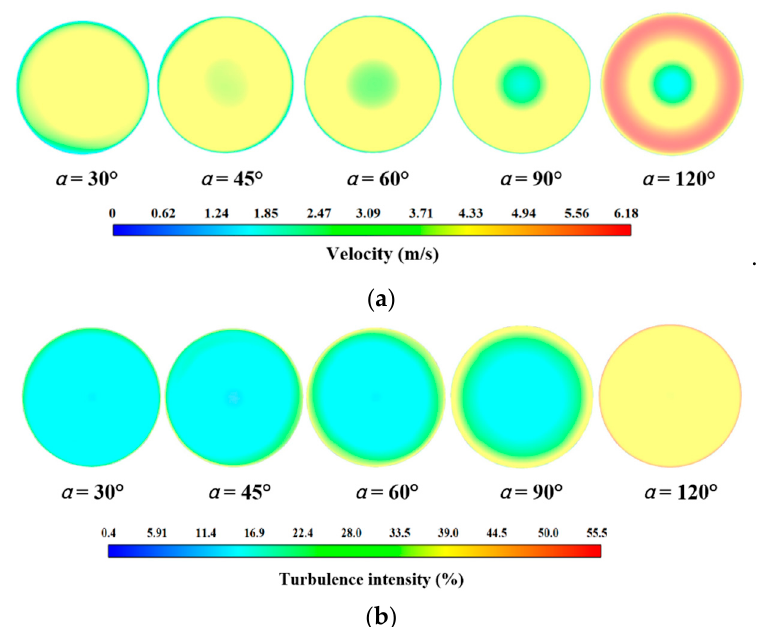
Figure 15. Flow velocity and turbulence intensity for different α values: ( a ) total velocity magnitude; ( b ) turbulence intensity.